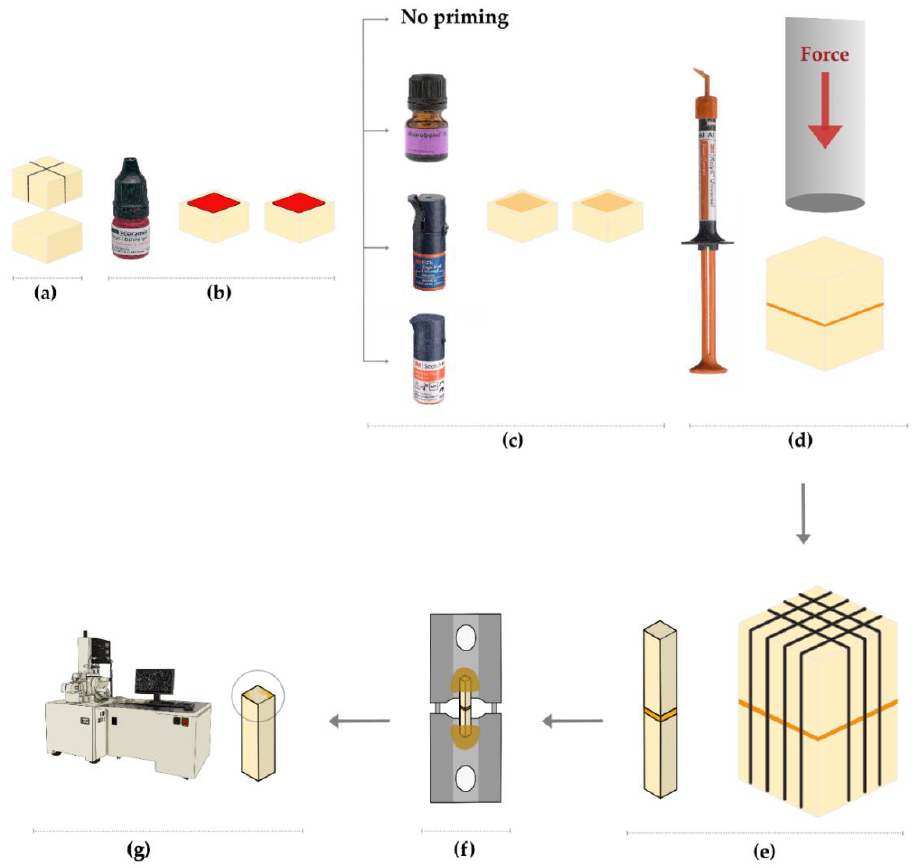
Figure 1. Schematic illustration of specimens ’ preparation and μTBS test . ( a ) Sectioning of ceramic blocks into discs; ( b ) acid etching with 5% HF; ( c ) priming of ceramic discs, control (no priming), MBN, SBU, SBP; ( d ) cementation of ceramic discs using RelyX Universal Resin Cement under 1 kg force; ( e ) sectioning of cemented discs into microbeams; ( f ) fixation of microbeams onto μTBS metal jig; ( g ) using a scanning electron microscope (SEM) to evaluate the failure/fracture mode of mi- crobeams with failure-mode patterns unidentifiable with a light